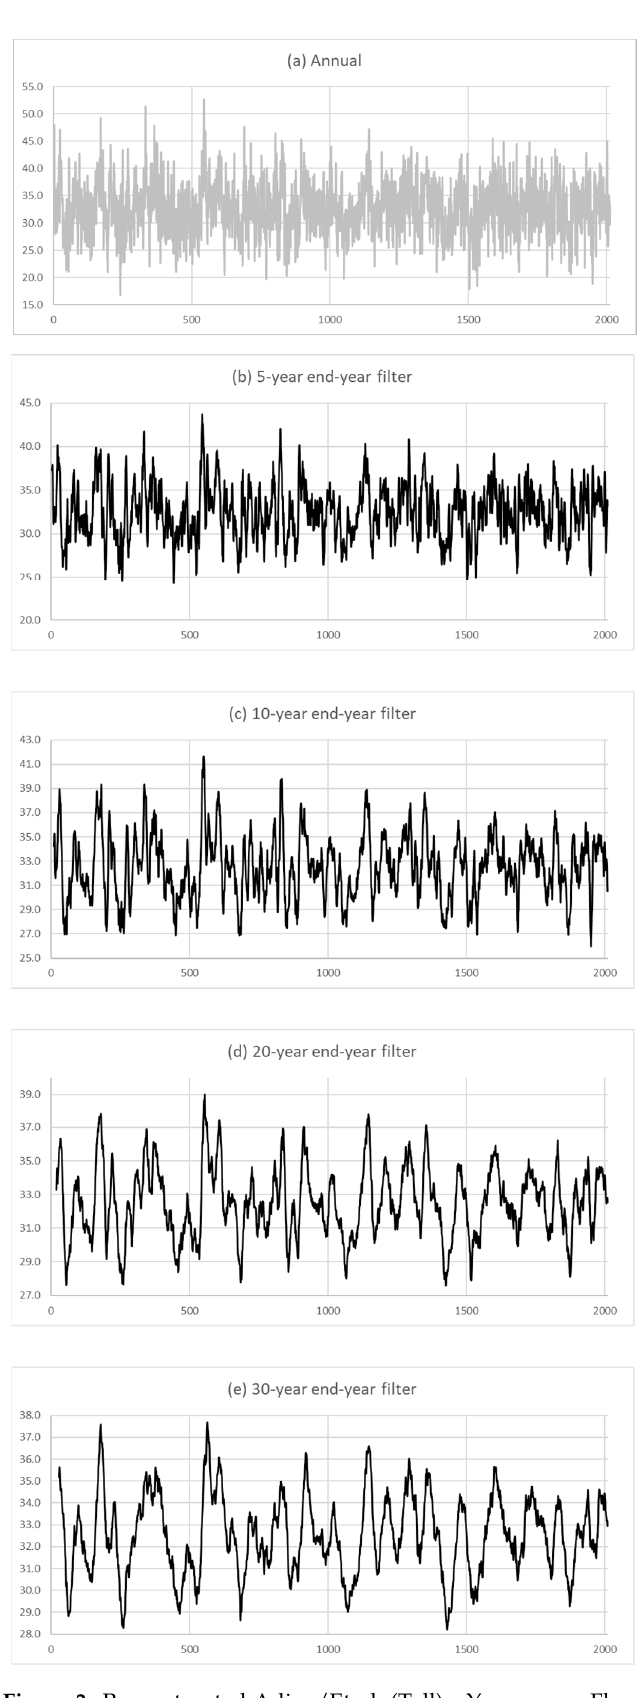
Figure 3. Reconstructed Adige/Etsch (Toll)—Year versus Flowrate (m 3 /s) from 0 to 2012 AD for ( a ) Annual, ( b ) 5-year, ( c ) 10-year, ( d ) 20-year and ( e ) 30-year end-year filters.